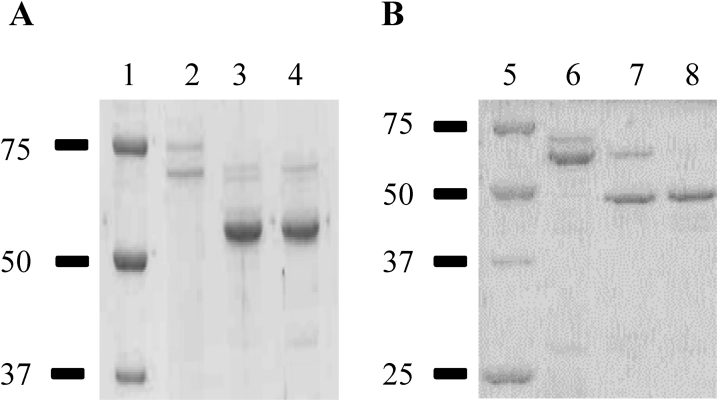
SDS-PAGE (12%) analysis of the protease-resistant fragments obtained after trypsin or chymotrypsin processing of the solubilized Cry3Aa (A) or Cry3Ca (B) protoxins. Lanes 1 and 5, molecular mass marker (size labeled in kD) a); lanes 2 and 6, Cry3Aa and Cry3Ca protoxins, respectively; lanes 3 and 7, activation with trypsin; lanes 4 and 8, activation with chymotrypsin.